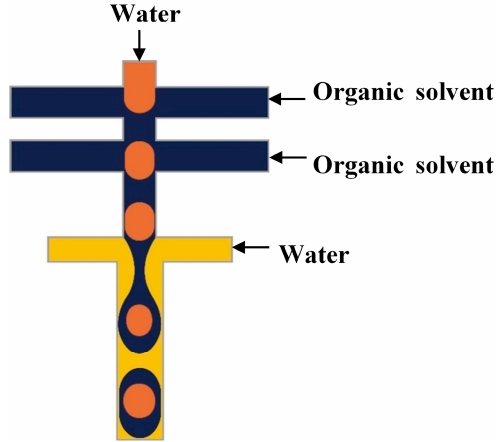
Figure 10. Drop maker arrays based on cross junction flow focusing geometry used to produce double emulsion droplets using two separate inlets for the middle phase [115].